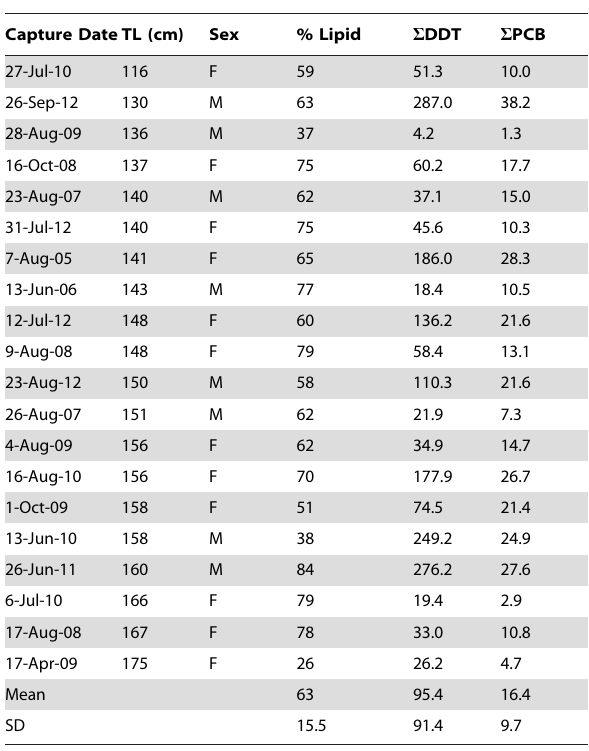
Table 1. Capture date, total length (TL), percent lipid concentration of the liver and liver concentrations ( m g/g, wet weight) for S DDT and S PCB for the YOY white shark samples.